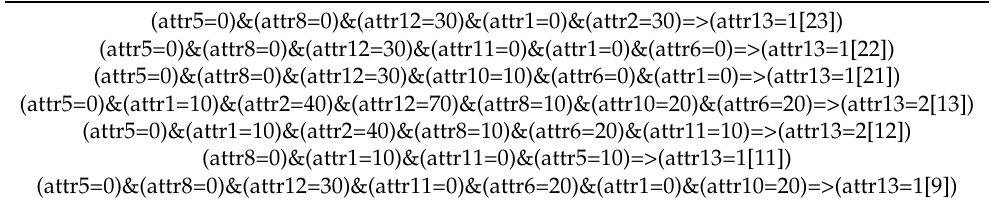
Table 4. Examples of real rules-LEM2 algorithm, Statlog (heart) Data Set [3], Rule statistics: 99 rules, Support of rules Minimal: 1, Maximal: 23, Mean: 3.1, Length of rule premises, Minimal: 4, Maximal: 10, Mean: 7.2, Distribution of rules among decision classes, Decision class 1: 43, Decision class 2: 56.